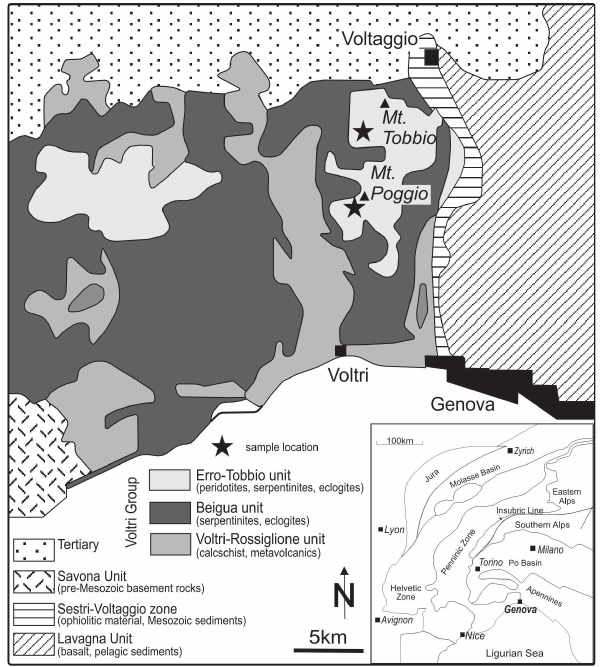
Fig. 1. Schematic tectonic map of the Voltri Group (after Scambel- luri et al., 1991). Serpentinites have been sampled close to Mt. To- bbio and Mt. Poggio as indicated by the